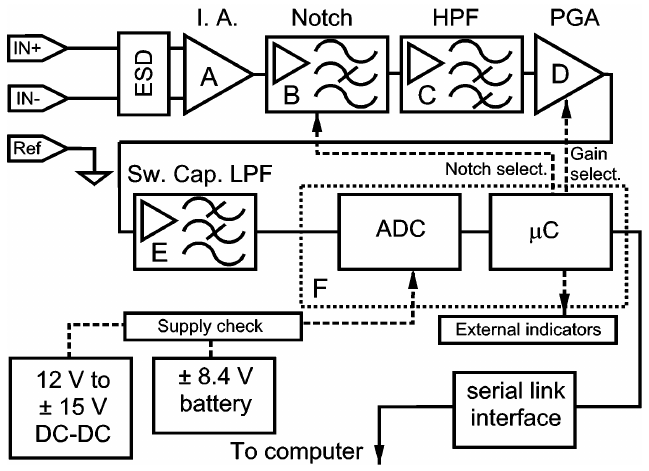
Figure 3. Signal conditioning electronics: front stage of the system. ESD: Electrostatic Discharge Protection. I.A.: Instrumentation Amplifier. HPF: High-Pass Filter. PGA: Programmable Gain Amplifier. Sw. Cap. LPF: Switched-Capacitor Low-Pass